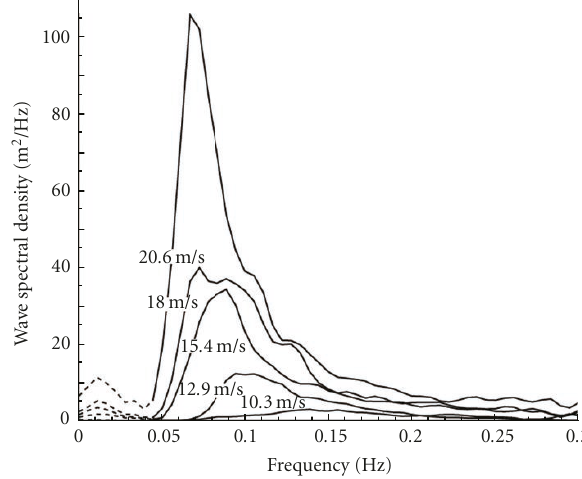
Figure 2: The Pierson-Moskowitz spectral distribution of a fully developed sea at di ff erent wind speeds [16, 18].